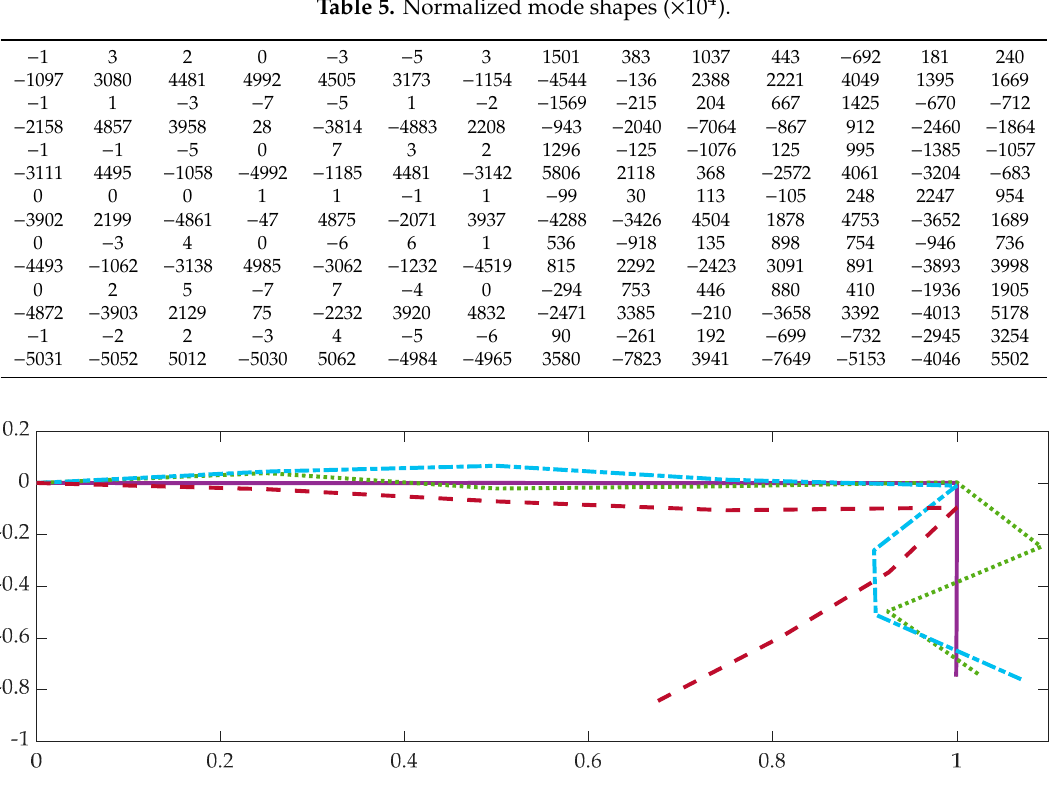
Table 5. Normalized mode shapes (×10 4 ).